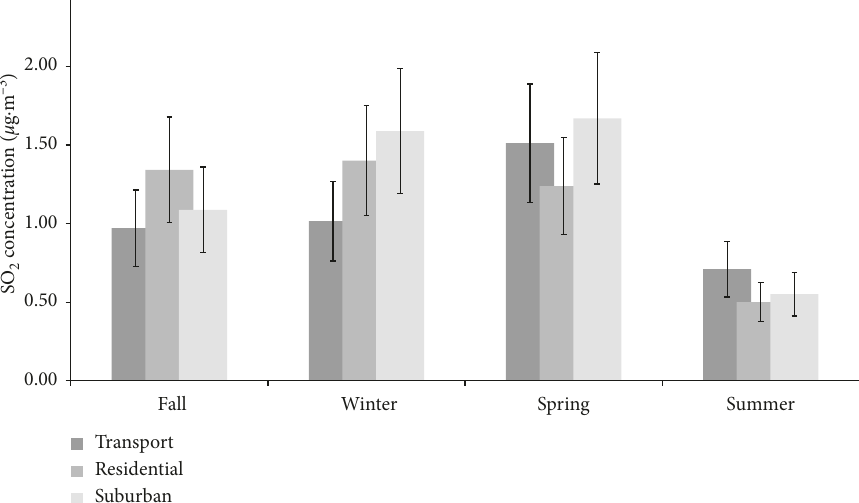
Figure 2: Seasonal variation of mean SO 2 concentrations for the entire study period from 3 November 2010 to 4 July 2011 (bar lines show 22.1% expanded uncertainty). ±